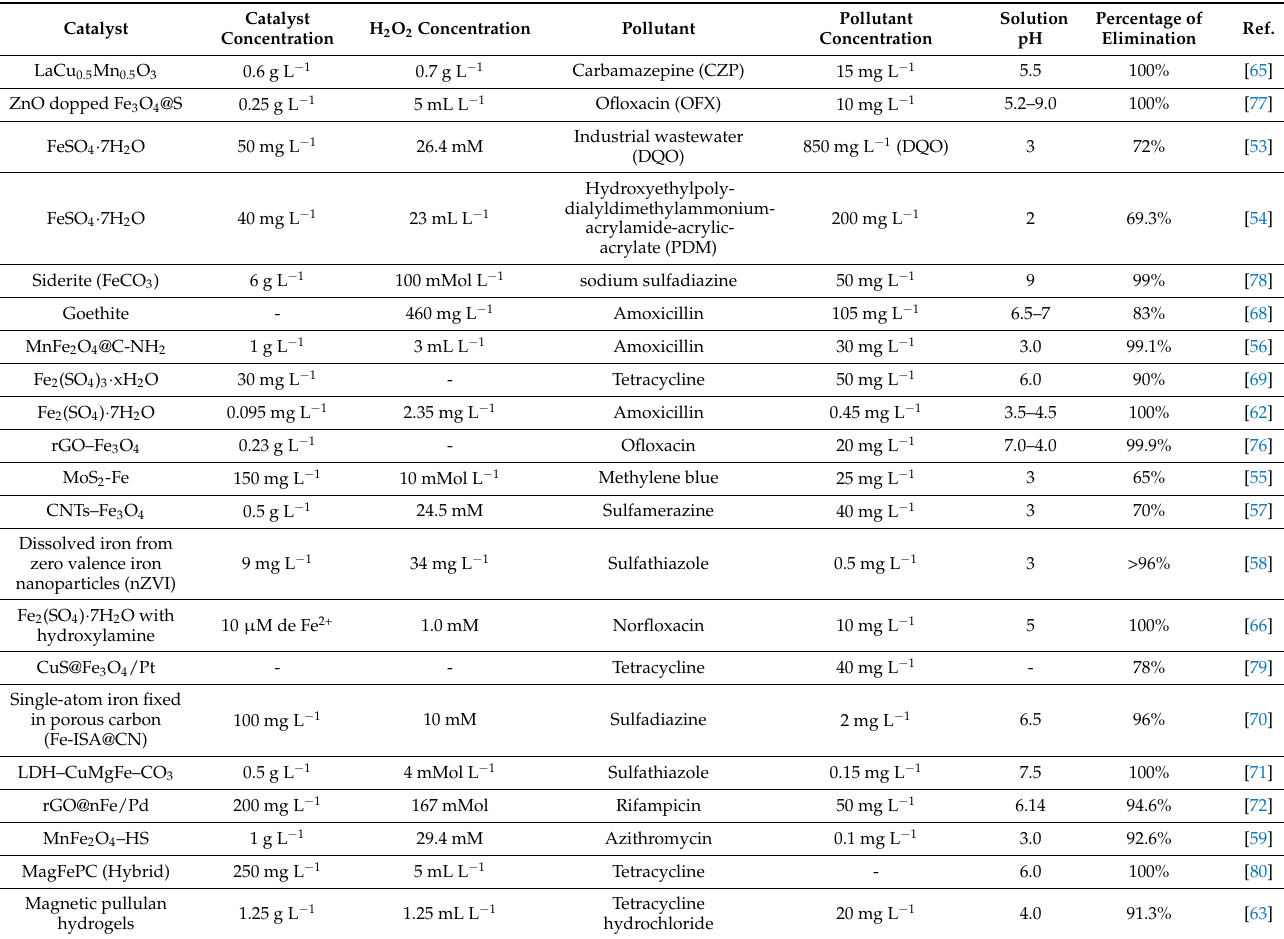
Table 1. Operating conditions for some Fenton